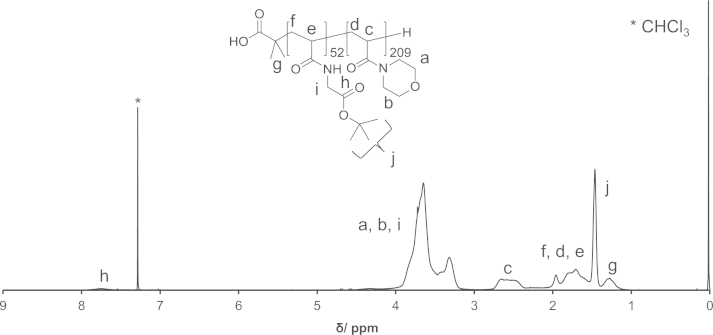
1H NMR spectrum of polymer (6).